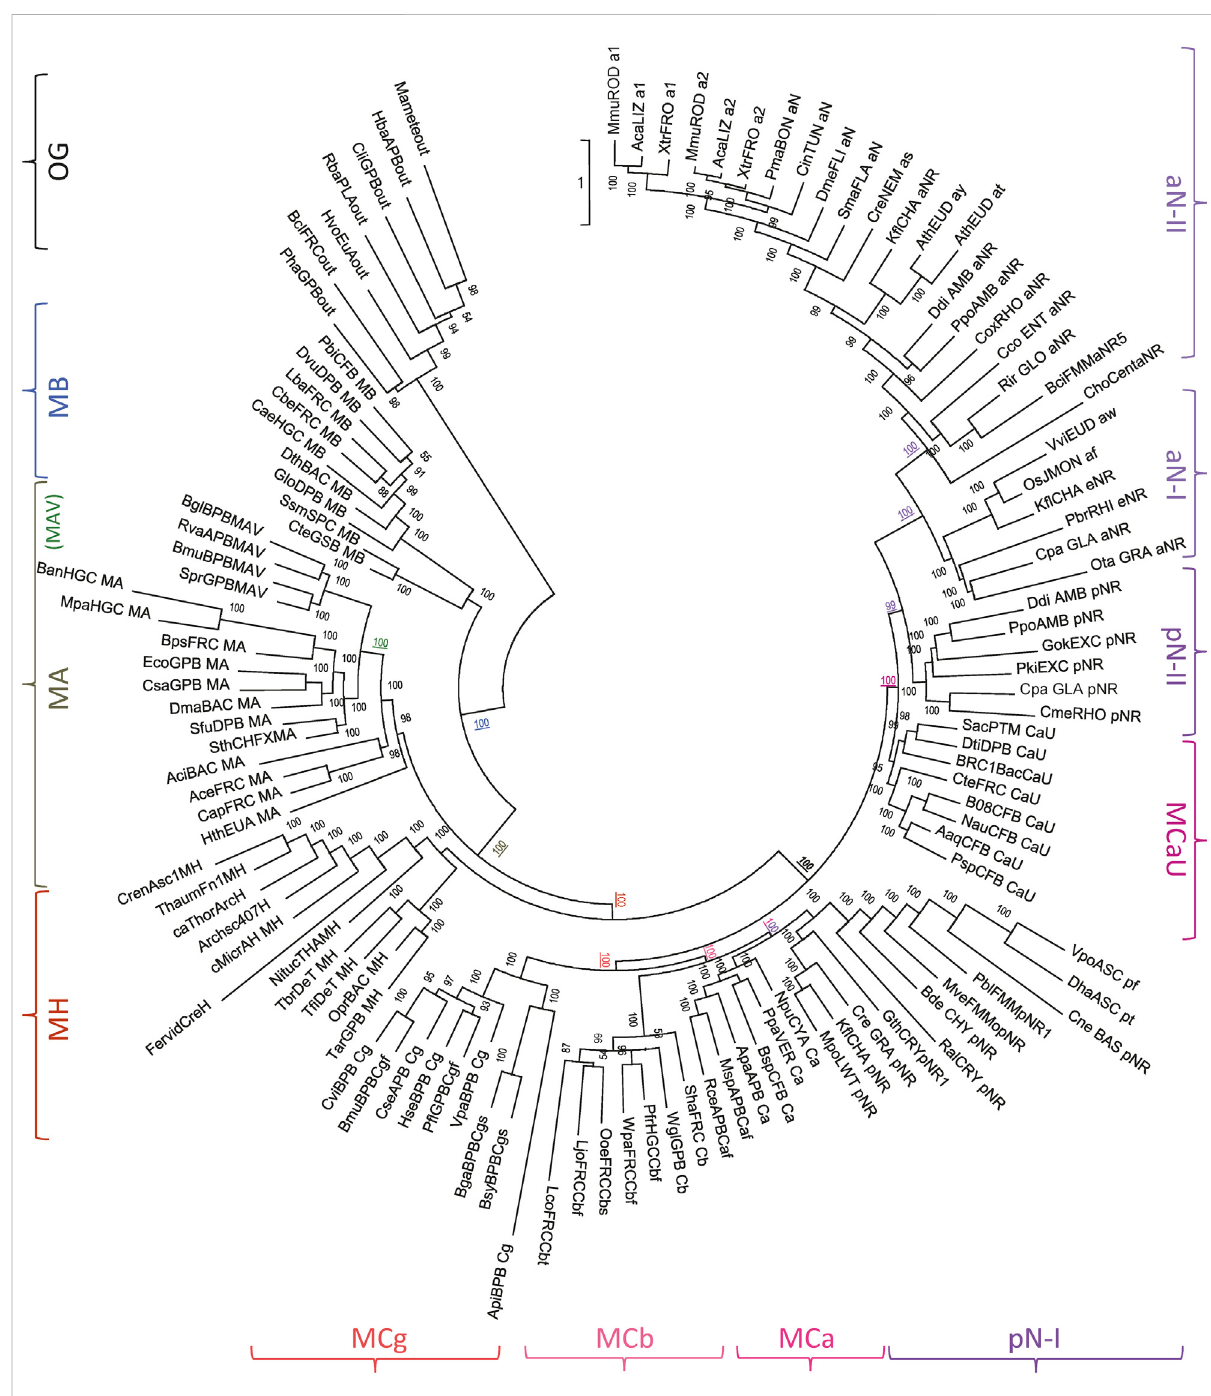
FIGURE 2 MntH H: prokaryotic precursor of Nramp. Phylogenetic analyses using 379 Slc11 PI sites identify MH as an evolutionary intermediate between MntH homologs of bacterial origin (MB, MA) and eukaryotic Nramp (aN and pN types, including MCs). The IQ-tree presented was inferred using the substitutionmodelUL3,MLestimateofa.a.statefrequency,freeratemodelofvariationamongsiteswith19categories(Leetal.,2008;Tri fi nopoulos et al., 2016). Symbols indicating Slc11 phylogroups are placed at the periphery of the tree and the con fi dence values for key nodes